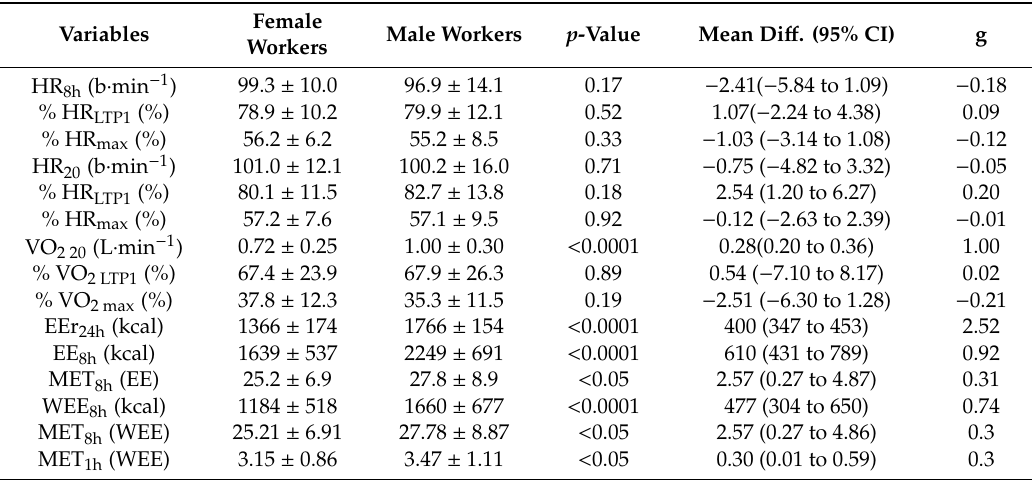
Table 4. Results of the measurements during a work shift with percentages based on the maximum heart rate (HR max ) and the heart rate at LTP 1 (HR LTP1 ).